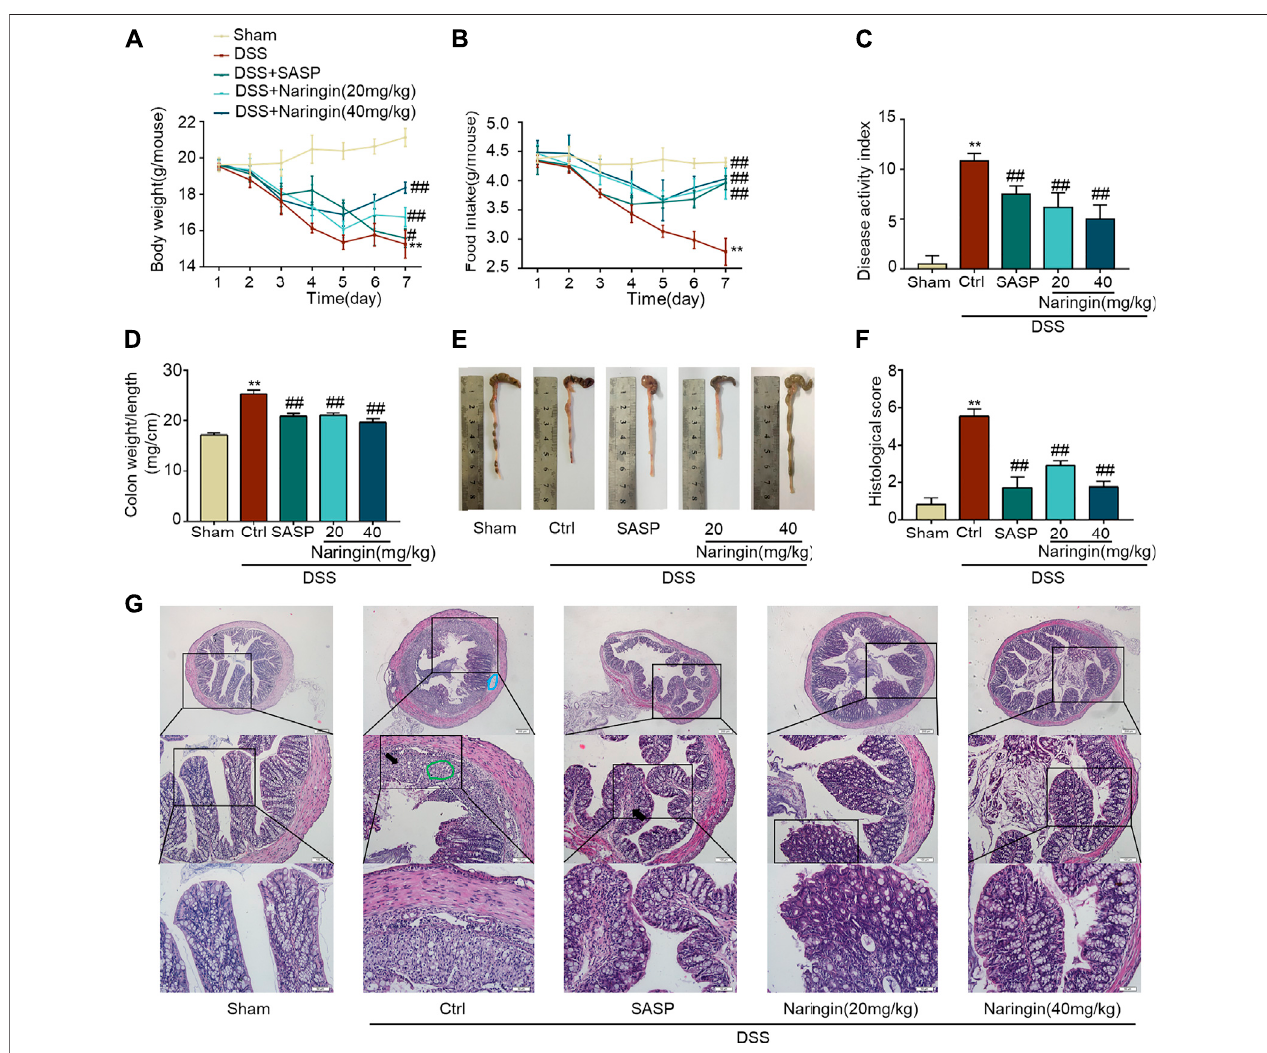
FIGURE2| NaringinamelioratesDSS-colitissymptoms.Colitissymptomswererecordedafter7 daysofnaringintreatment.Effectsofnaringinon (A) bodyweight, (B) food intake, (C) DAI, (D) colon weight-to-length ratio, and (E) gross morphology of colon tissue. (F) Total histological score was calculated as the sum of epithelial damage and histological score. (G) H and E staining of mice colonic tissue. Scale bars, 200, 100, 50 μ m. Green ring indicates damaged villi structure; black arrow indicatesin fi ltrationofin fl ammatorycells;blueringindicatessubmucosaledema.Dataareexpressedasmean ± SD.Valuesintheshamgrouparesetto100%,and other values are given relative to the sham group. ** p < 0.01 compared with sham group; ## p < 0.01 compared with DSS-colitis group; n (cid:2) 6 samples.